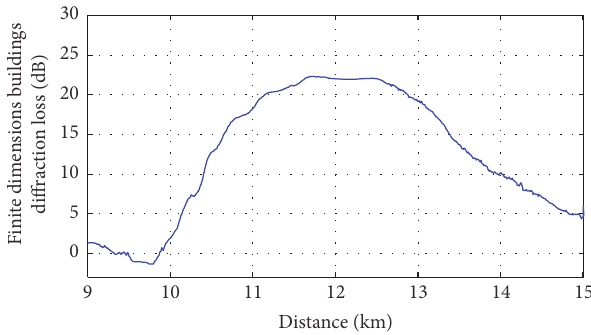
Figure 13: Finite dimensions buildings diffraction.